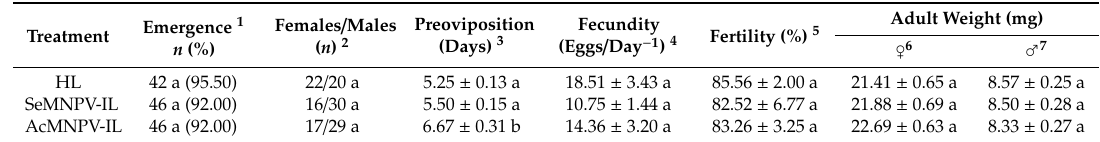
Table 4. Side e ff ects of the baculoviruses SeMNPV and AcMNPV on the imaginal parameters of Chrysoperla carnea after consumption of healthy and LC 95 -infected L 2 Spodoptera exigua larvae.